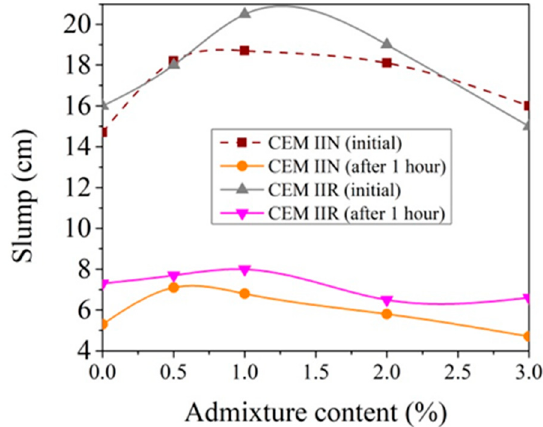
Figure 7. Slump of concrete mixtures with CEM IIR and CEM IIN dependence of CN content (0 h—measured instantly after mixing, 1 h—measured after 1